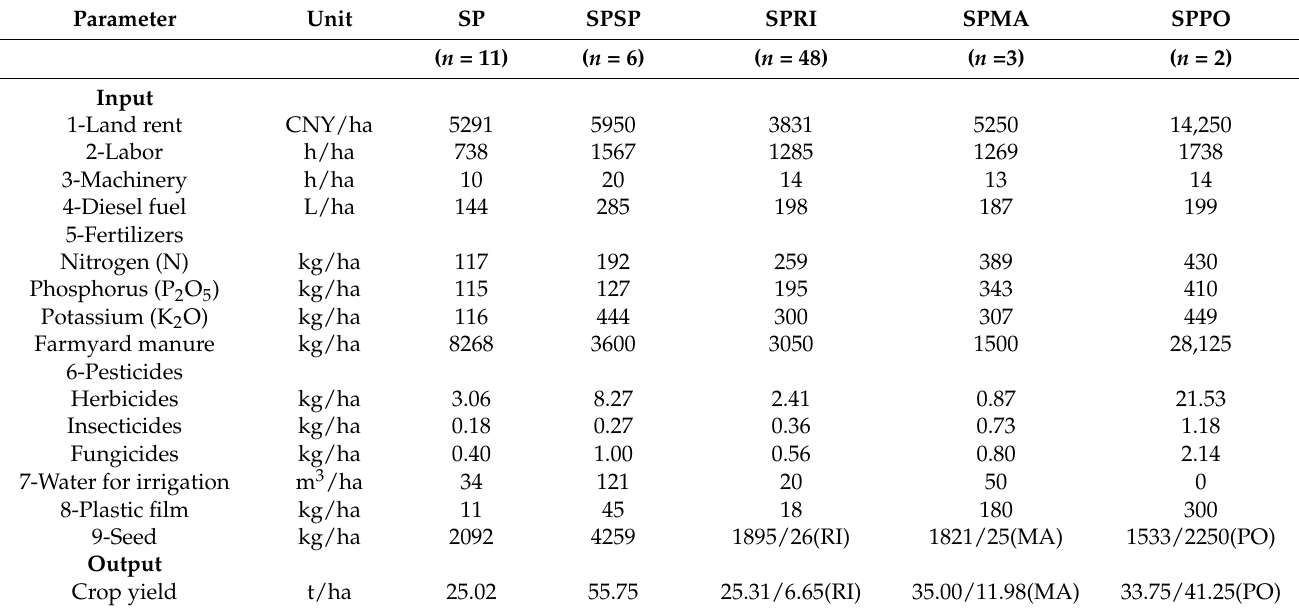
Figure 1. Distribution of sample sites for face-to-face questionnaire survey in Guangdong. SP, sweet